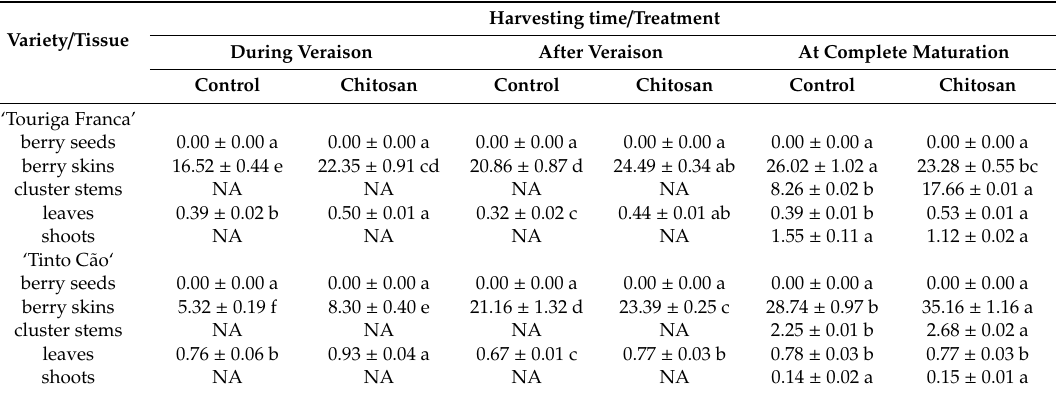
Table 3. The total anthocyanin